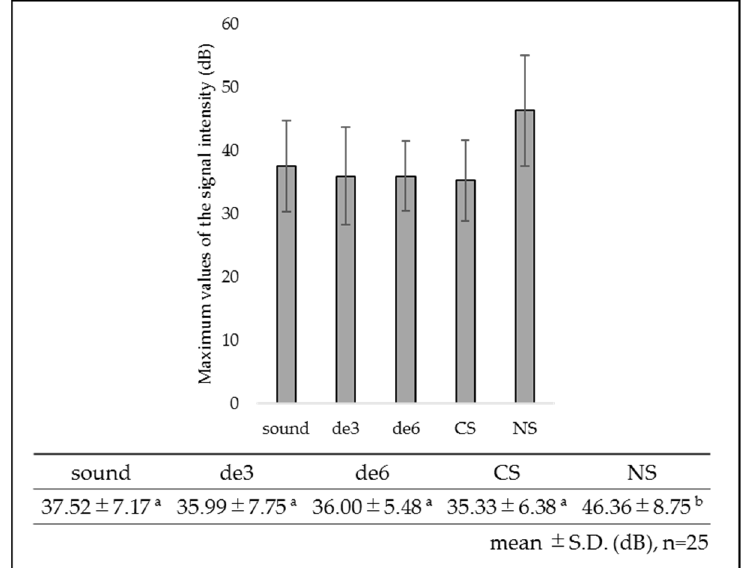
Figure 5. Maximum values of signal intensity (dB) for each group. NS showed the highest maxi- mum value of signal intensity within the groups. The same lowercase letters indicate no signifi- cant differences among the values ( p > 0.05).